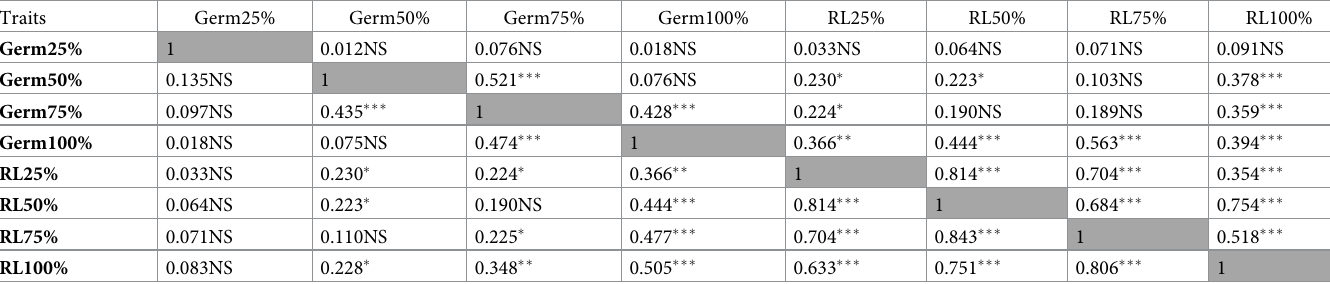
Table 1. Correlation among eight parameters studied on lettuce treated with WSE derived from SDRS (lower half) anf F3 (upper half) lines.